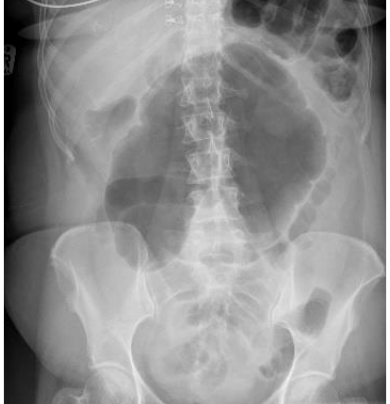
Figure 1. Abdominal radiograph again demonstrating classical features of CV. The patient was